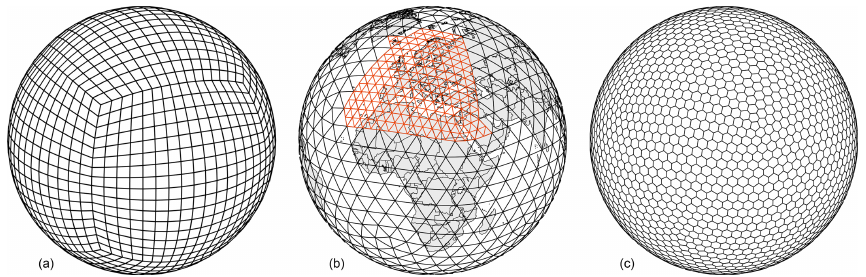
Figure 1. (a) A cubed-sphere grid. (b) An icosahedral (triangular) grid with additional refinement over Europe, as indicated in red. (c) An icosahedral (hexagonal)